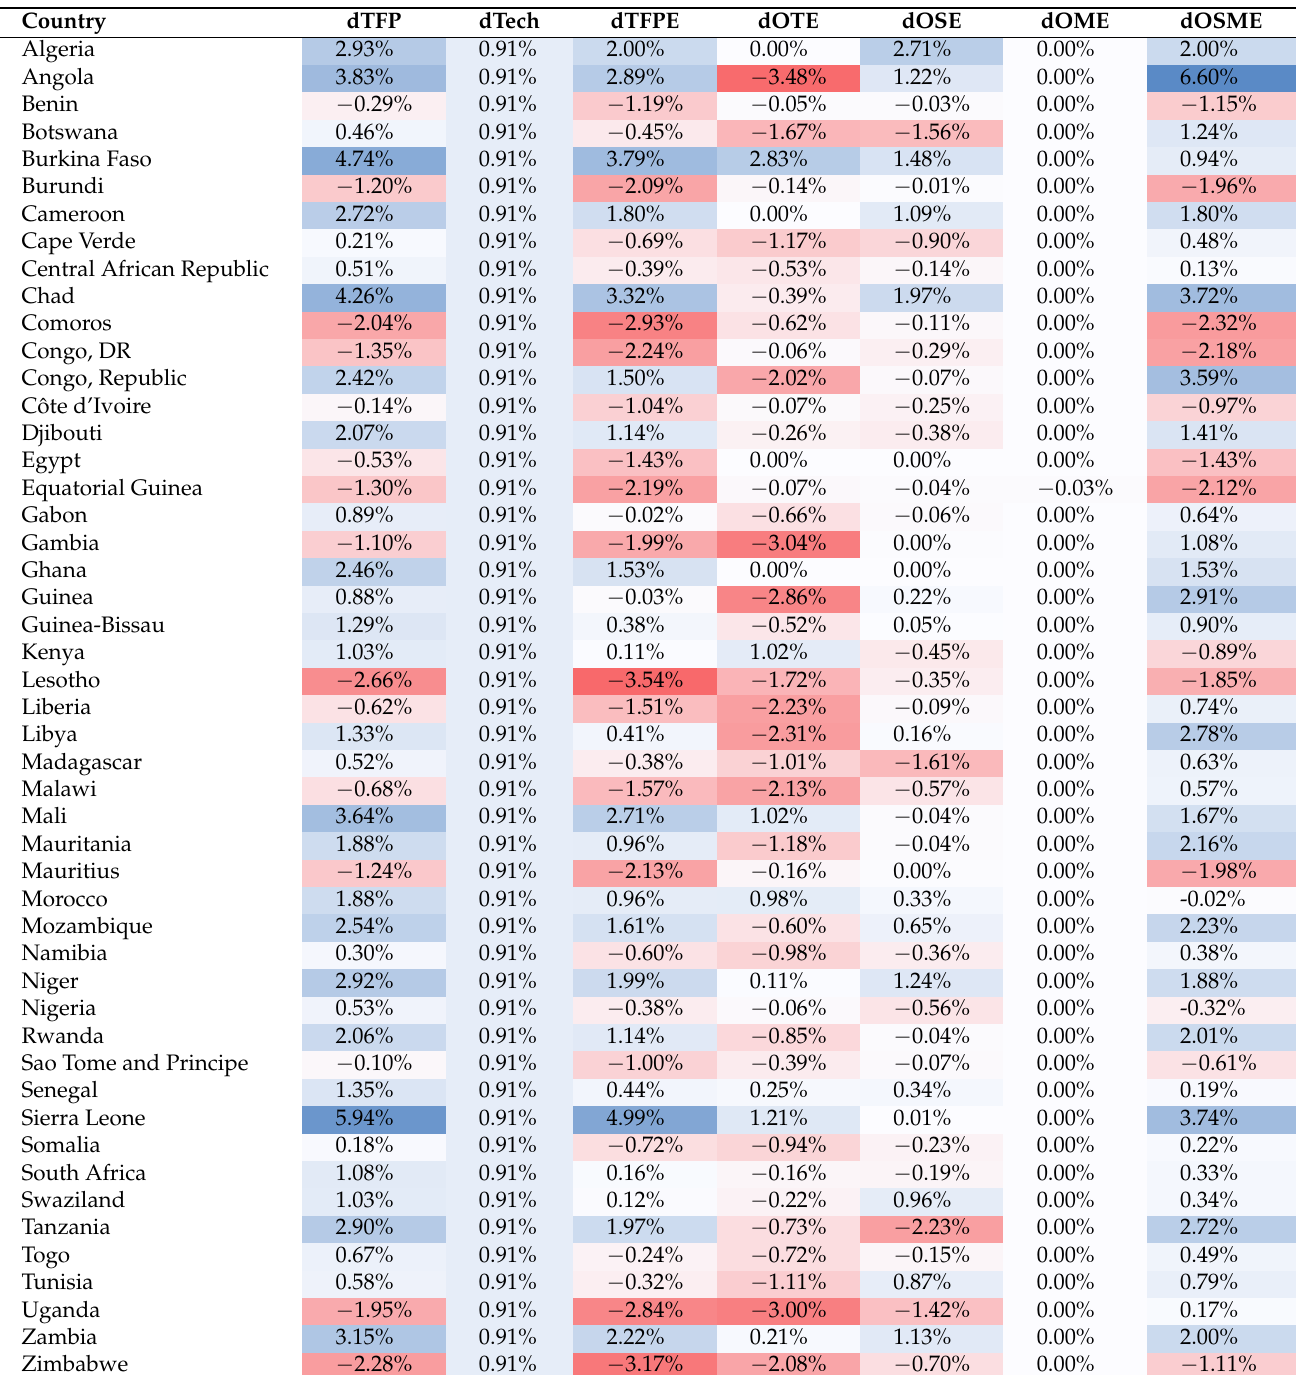
Note: Grey to blue colour represents an increase in productivity, pink to red denote a decline in productivity. The darker the colour the larger the increase or